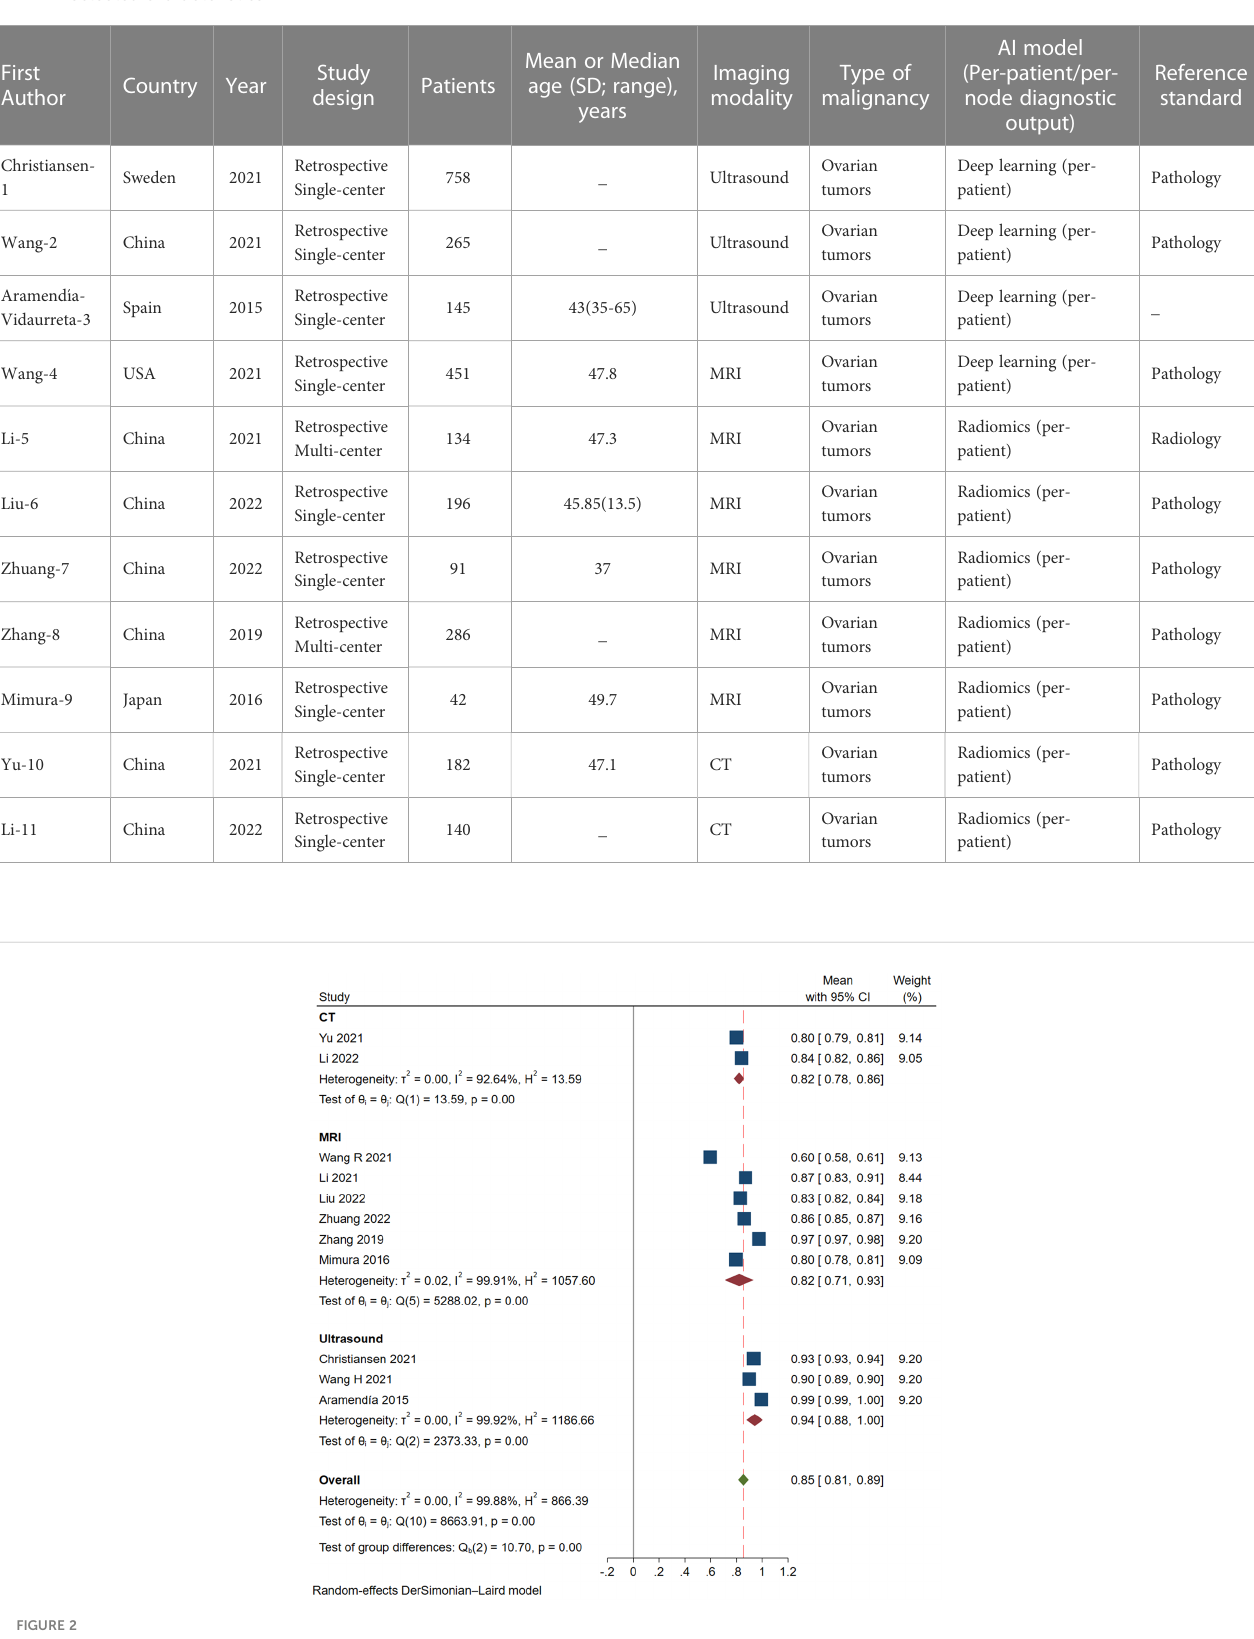
TABLE 2 Selected characteristics.